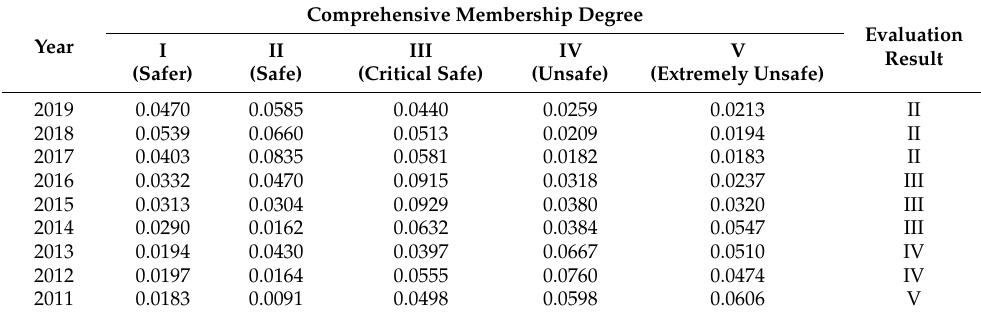
Table 6. Chongqing’s assessment results (2011–2019) of water security based on